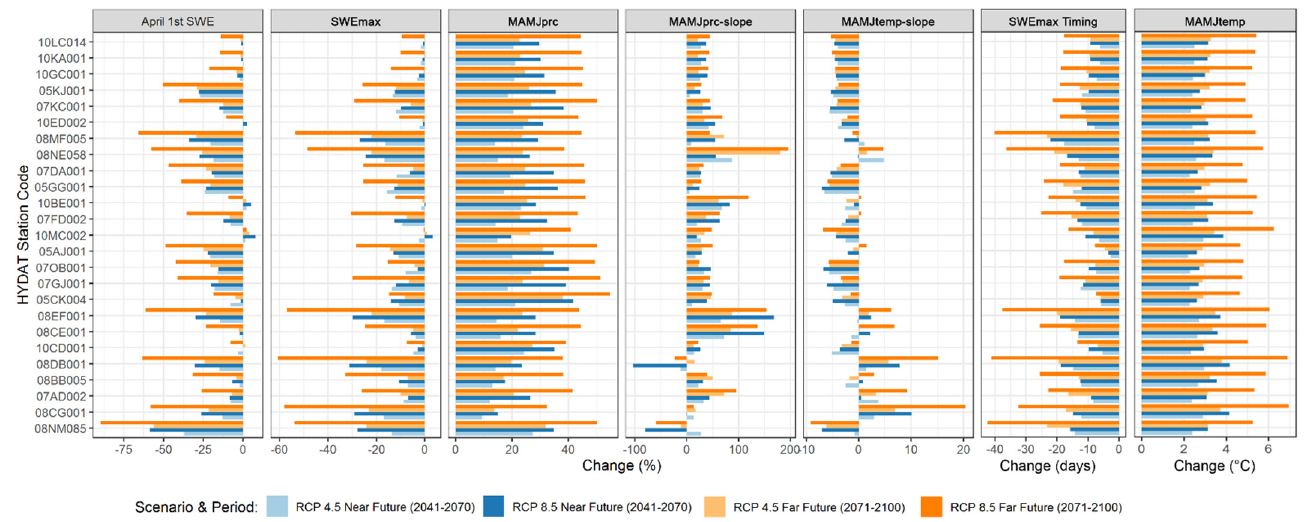
Figure 6. Projected changes in catchment-averaged predictor variables between each of the two future periods (2041–2070 and 2071–2100) and the baseline period (1976–2005) based on the CanRCM4 model projection over the study area corre- sponding to the RCP4.5 and RCP8.5 scenarios.